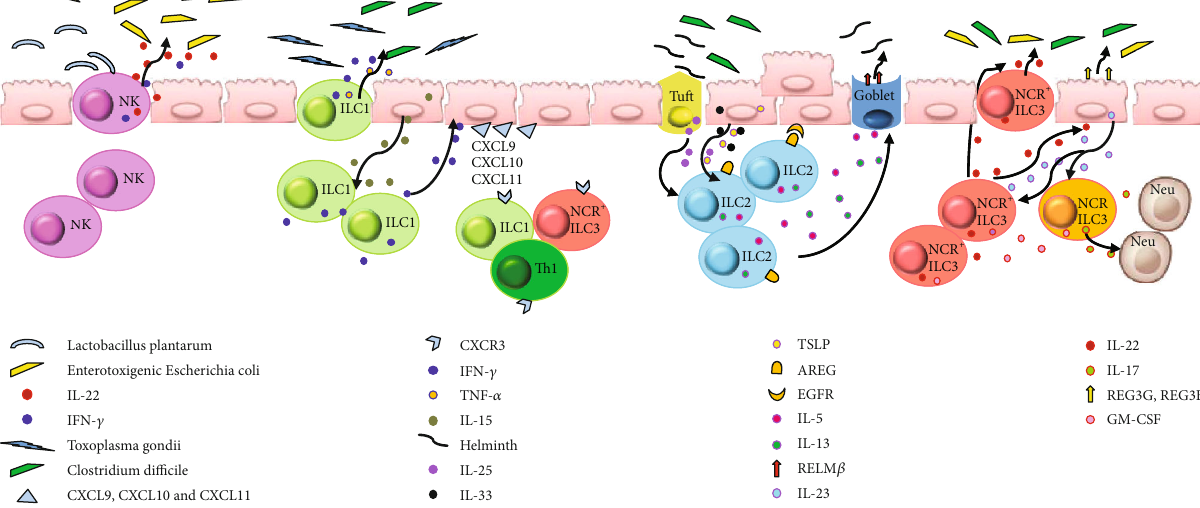
Figure 1: The multiple roles of innate lymphoid cells (ILCs) in intestinal tissue immune defense and tissue remodeling. NK cells can attenuate intestinal damage by producing IL-22 and IFN- γ after infection. ILC1s mediate protection via IFN- γ and TNF- α production after infection and attract CXCR3 + leukocyte accumulation. ILC2s produce multiple important e ff ector molecules after activation, promote intestinal repair, and limit parasitic infections. In response to IL-23 stimulation, NCR + ILC3s and NCR − ILC3s mainly produce IL-22 and IL-17, respectively, and GM-CSF from both kinds of cells, and participate in homeostasis of the